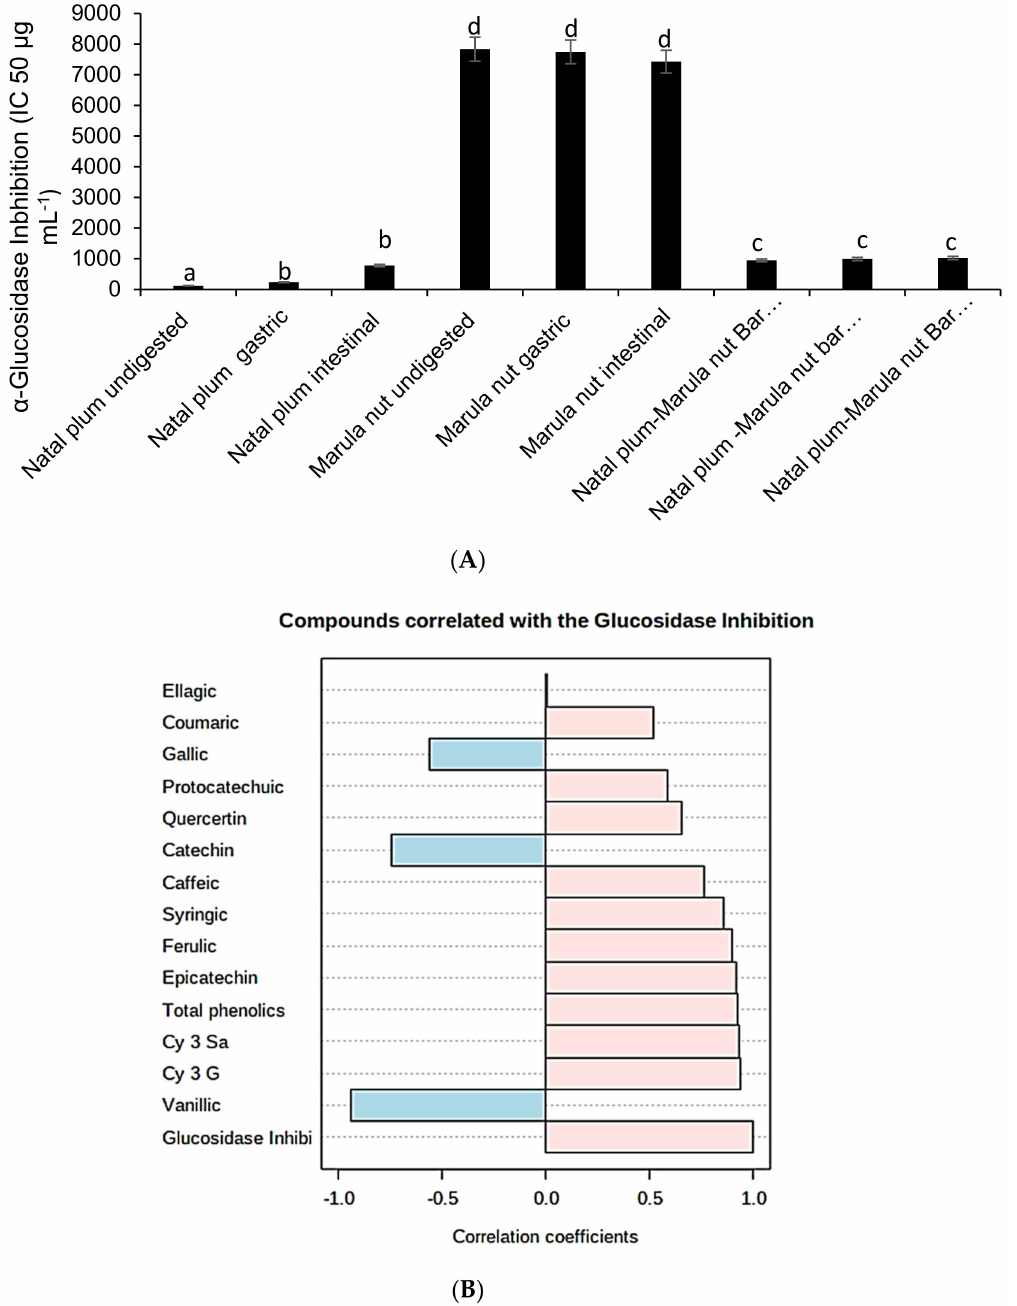
Figure 7. ( A ) Effect of simulated digestion on α -glucosidase inhibition capacity of Natal plums, Marula nuts and the bar. ( B ) Correlation of α -glucosidase inhibition capacity with phenolic